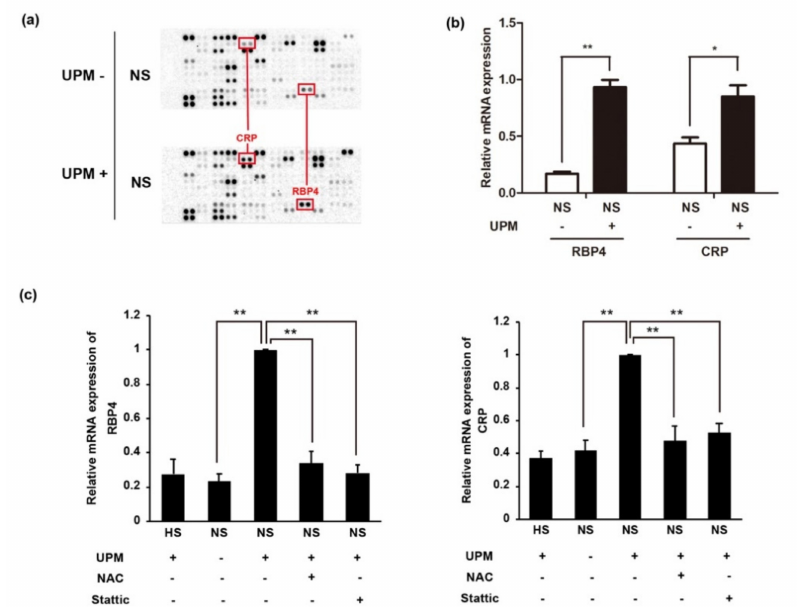
Figure 6. Complement activation induces the expression of inflammation-related proteins in UPM- treated HUVECs. Normal human serum was added to UPM- or vehicle (5% methanol)-treated HUVECs for 1 h, followed by replacement of the medium and incubation for 24 h. RNA and culture supernatant were collected to analyze mRNA and protein expression, respectively. ( a ) Antibody array with the supernatant from UPM-treated HUVECs using a Proteome Profiler Human XL Cytokine Array Kit from R&D Systems. The red box indicates the upregulated proteins in the supernatant from UPM-treated cells (UPM+) compared to the vehicle-treated cells (UPM-). CRP: C-reactive protein, RBP4: retinol binding protein 4. ( b ) The mRNA expression of complement activation-related proteins (RBP4 and CRP) in UPM-treated HUVECs with human serum. The mRNA expression was analyzed by RT-qPCR. Results are shown as mean ± SD, n = 3, Student’s t -test. * p < 0.05, ** p < 0.01. ( c ) Suppression of the mRNA expression of complement activation-related proteins (RBP4 and CRP) in UPM-treated HUVECs incubated with human serum by NAC or STAT3 inhibitor, stattic. NAC was added for 3 h before UPM treatment. Stattic was added to HUVECs 2 h before human serum treatment. Results are shown as mean ± SD, n = 3, one-way ANOVA and multiple comparisons. * p < 0.05, ** p <